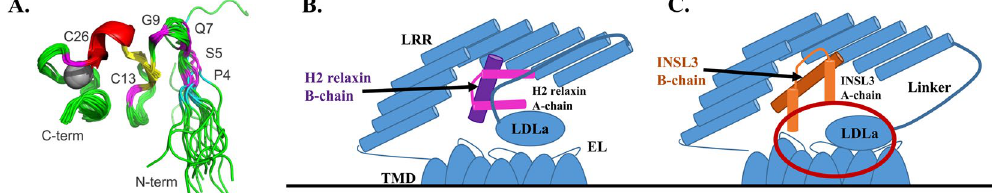
Figure 7. ( A ) Structure of the RXFP2 LDLa module (pdb: 2m96) showing the mainchain positions of Pro4 in cyan Ser5, Gln7, Gly9, Cys13 and Cys26 in magenta. The Ca 2 + is represented as a grey sphere. ( B , C ) Diagrammatic representation of the extracellular portion of RXFP2 (blue) demonstrating proposed mechanism of activation in response to H2 relaxin (pink) and INSL3 (orange). The B-chain of the two peptides (labelled and in darker colour) sit at different orientations to one another, with relaxin at a 45° angle across a more restricted portion of the LRRs than INSL3, which requires more contacts and sits perpendicular to the LRR concave surface 41 . While the final active conformation of receptor in response to relaxin is driven primarily by the LDLa module, the INSL3 response also involves key residues in the N-terminus of the A-chain (circled in